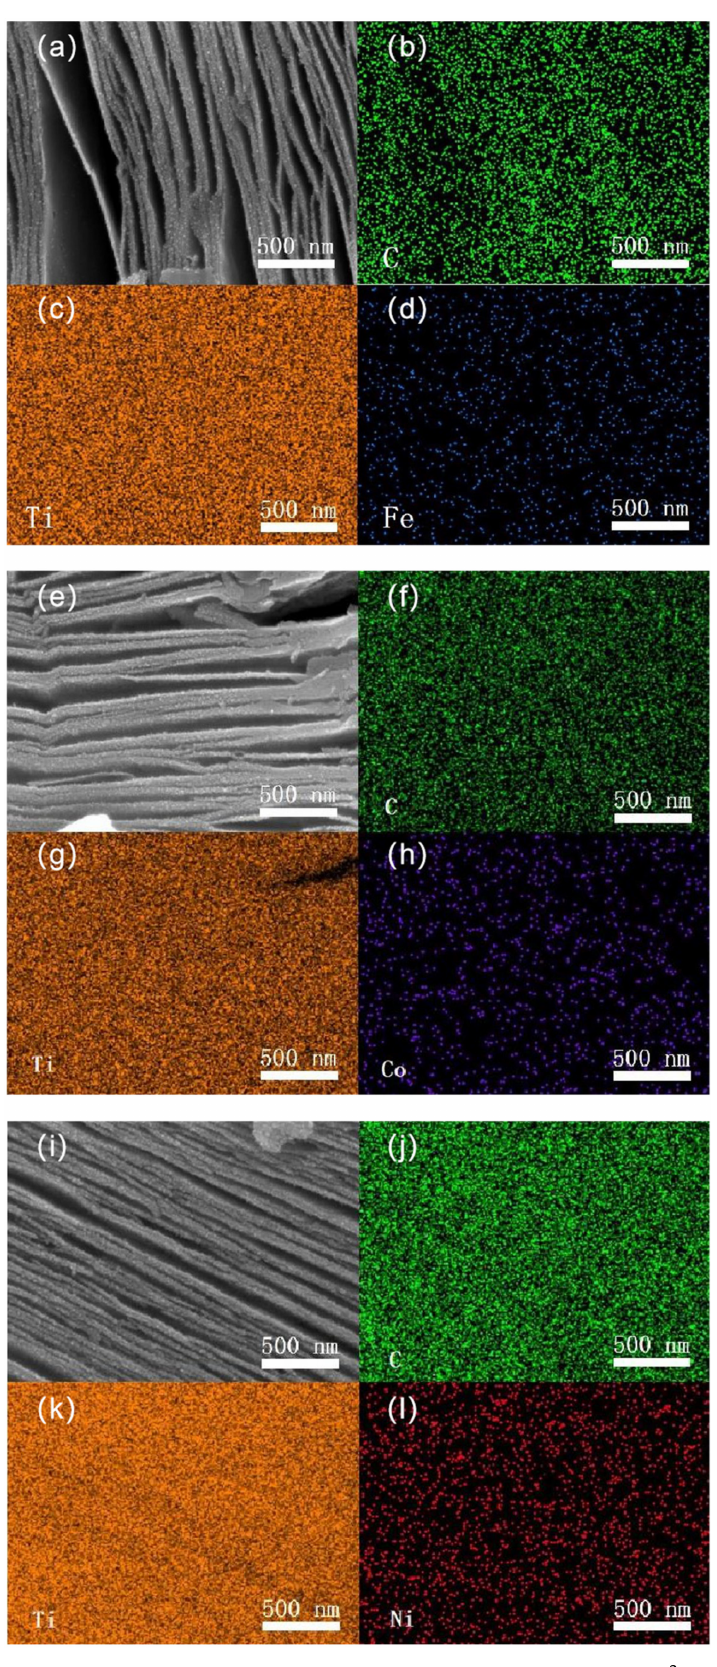
Figure 3. SEM and corresponding EDS mapping images of Ti 3 C 2 /Fe 3+ /Co 2+ /Ni 2+ :Ti 3 C 2 /Fe 3+ ( a – d ), Ti 3 C 2 /Co 2+ ( e – h ), and Ti 3 C 2 /Ni 2+ ( i – l